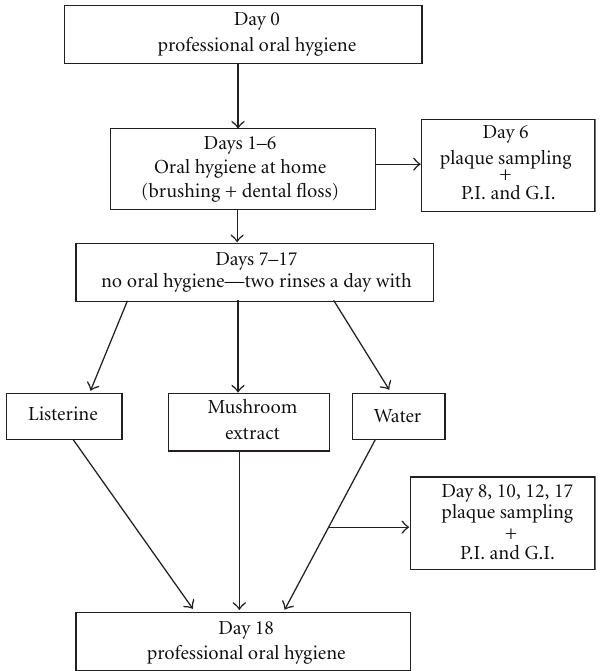
Figure 1: Outline of the study. PI, plaque index; GI, gingival index.